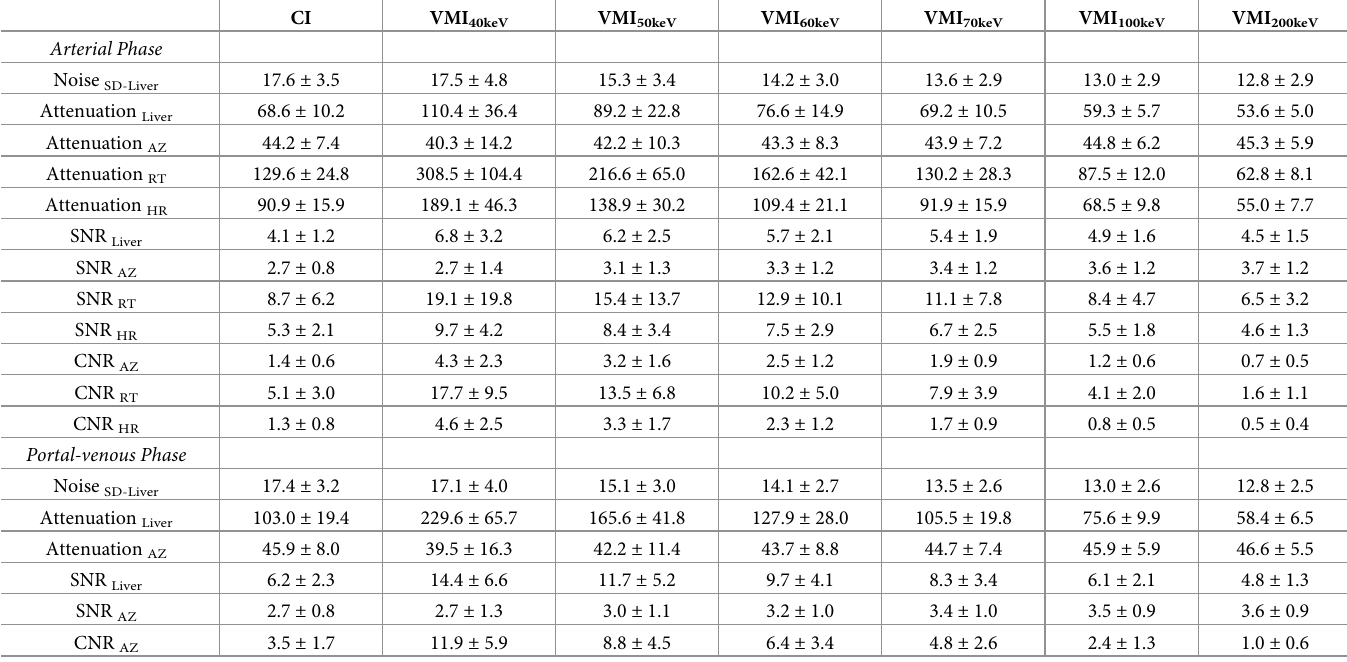
Table 4. Results of quantitative